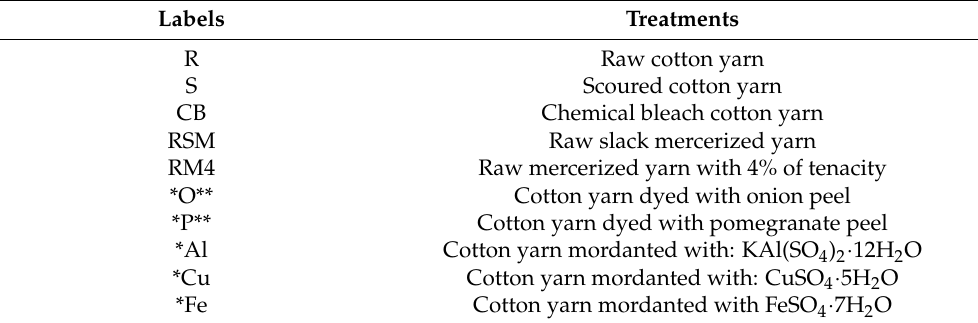
Table 1. Labels and